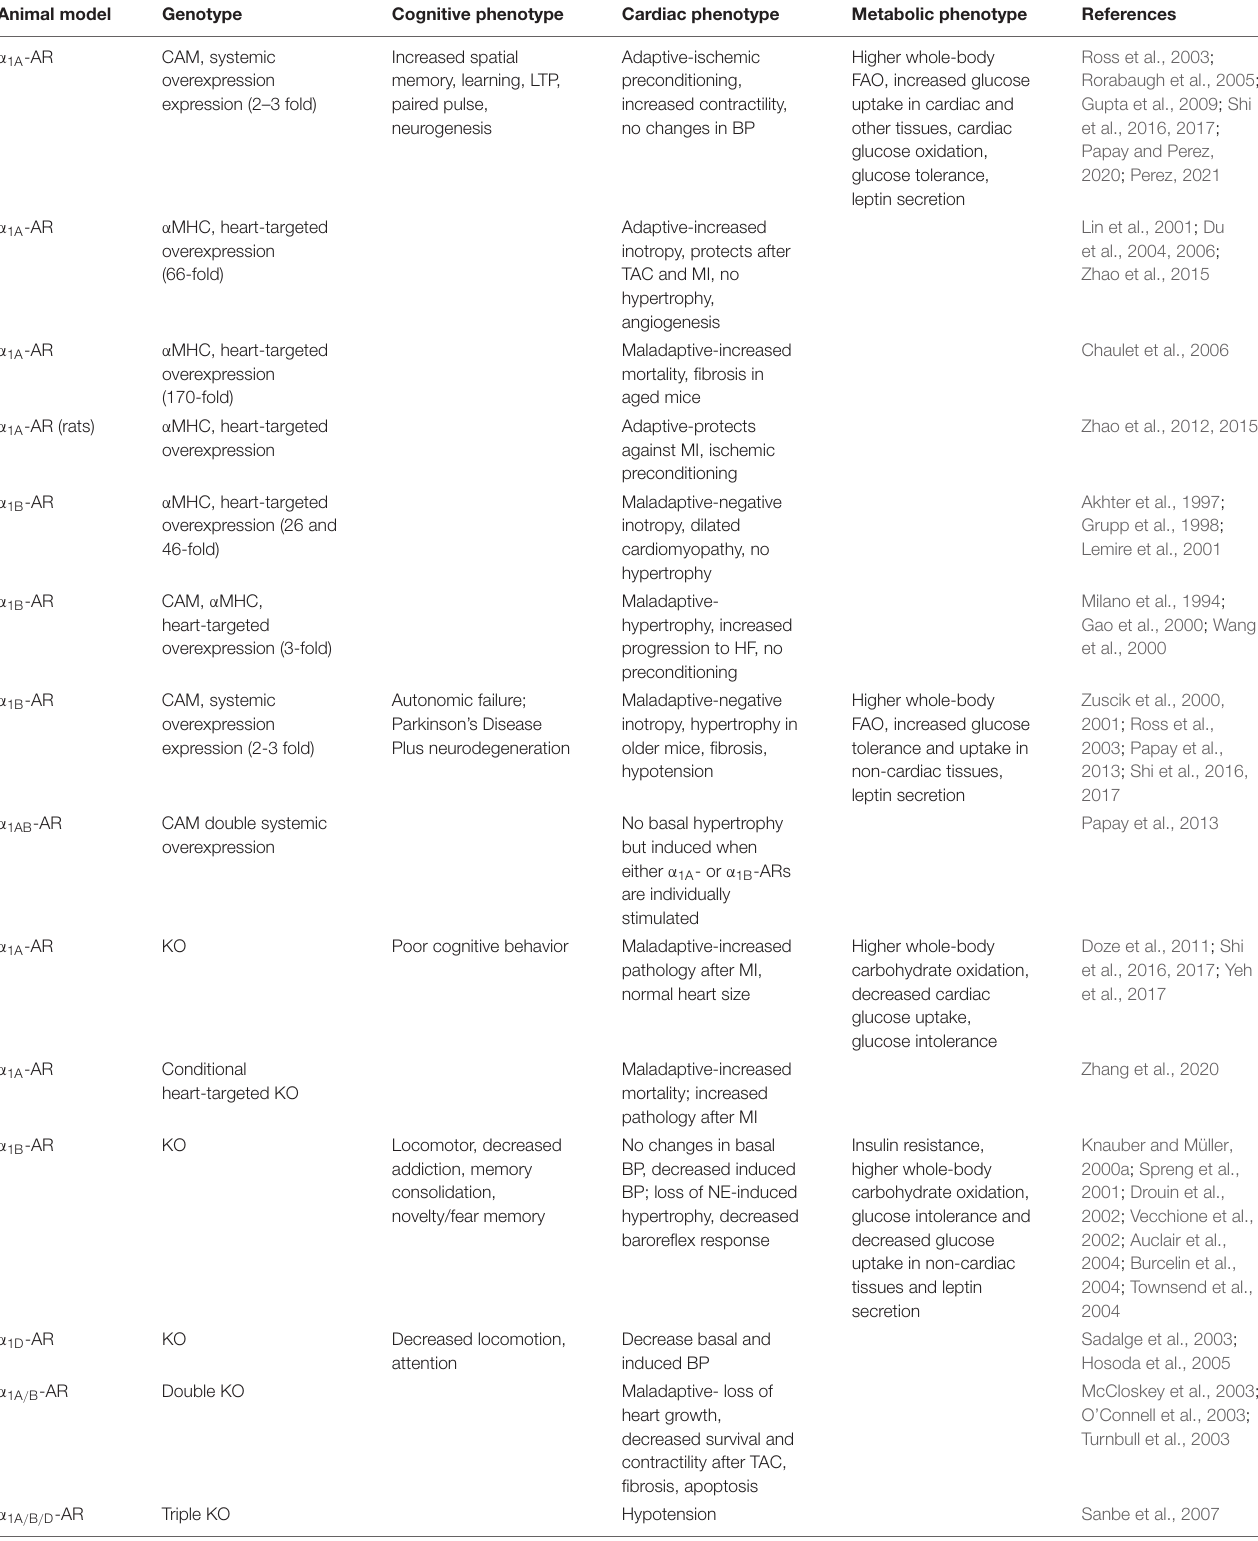
TABLE 2 | Genetic animal models of the α 1 -AR